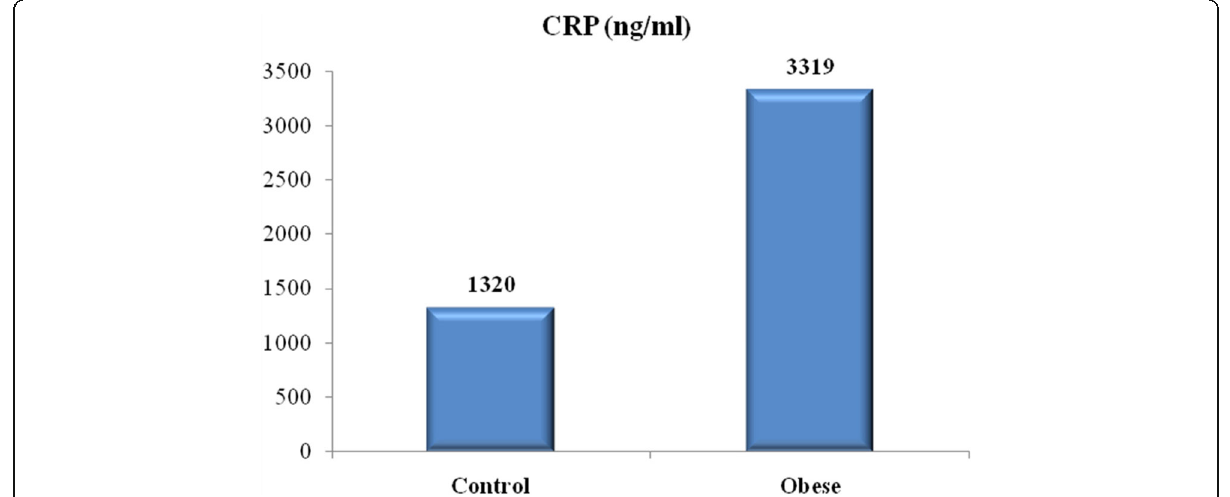
Fig. 1 Comparison of CRP levels between control and obese